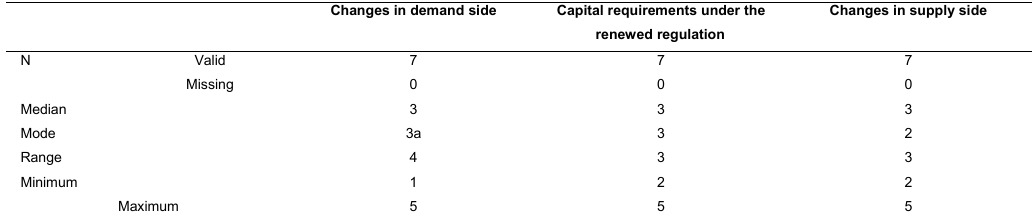
Table 6 . Impact of different factors on the possible change in credit